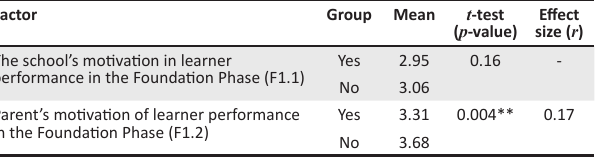
Effect ( p -value) size ( r )